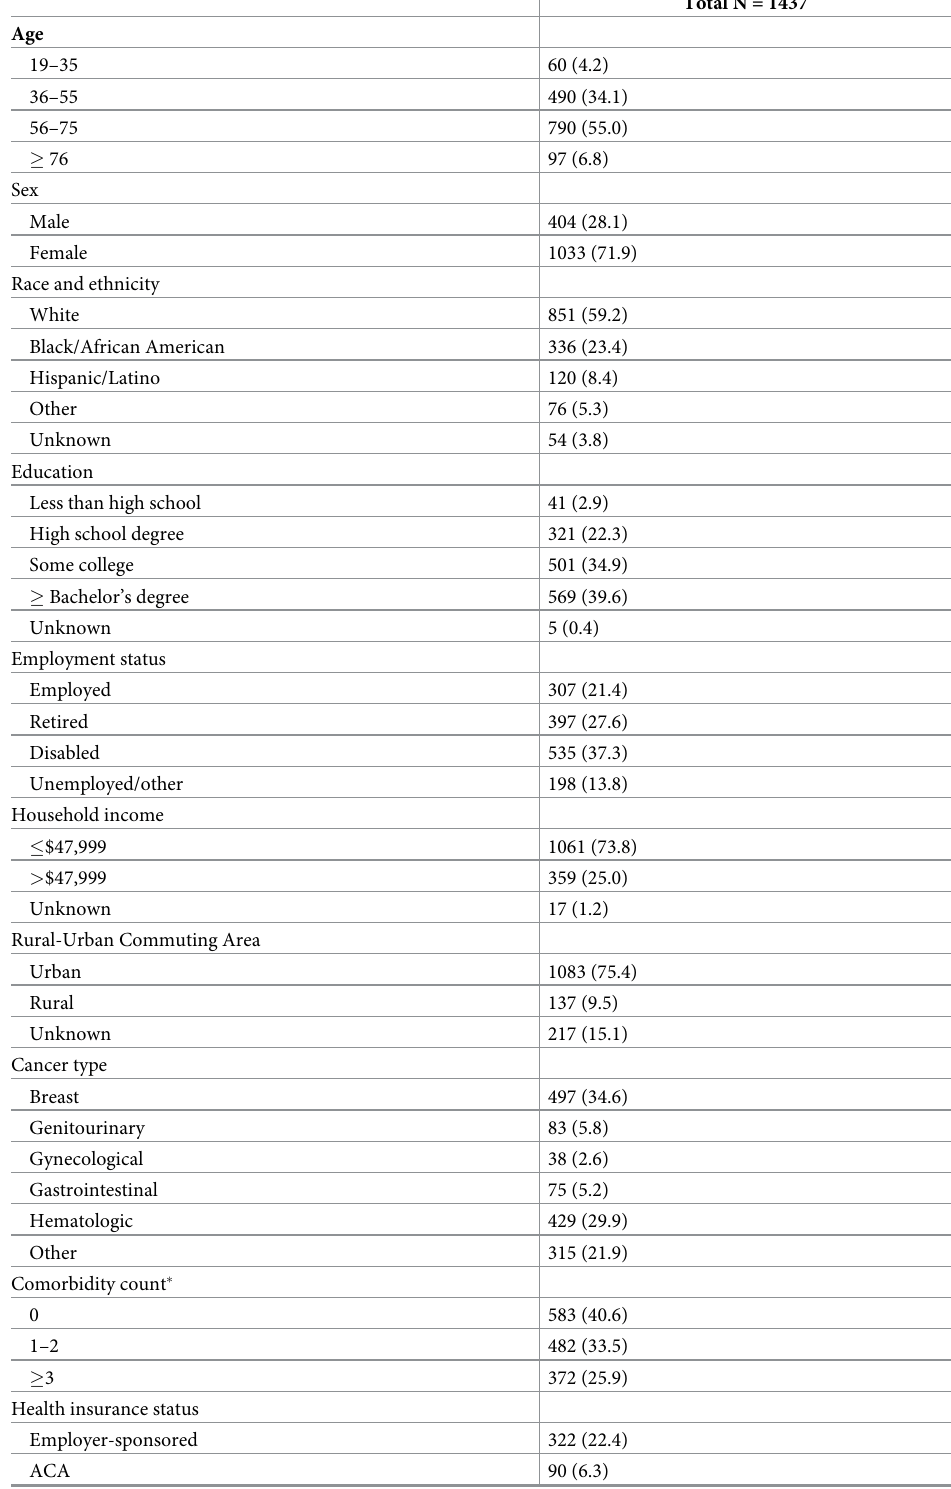
Table 1. Respondent sociodemographic and clinical characteristics (N =